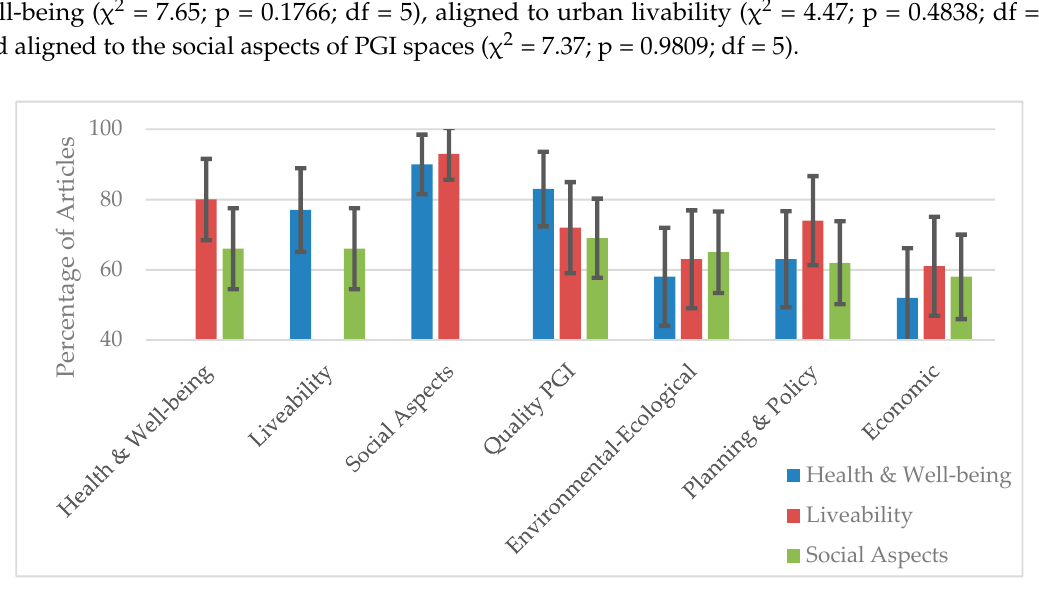
Figure 9. The collated rates of reporting (± 95% CIs of the proportions) of research focuses for the contribution that PGI spaces make to urban livability with respect to the key indicators of human health and well-being, livability in its own right, and the social aspects of PGI spaces. Percentages add to greater than 100% as articles reporting multiple focuses reported in more than one category.